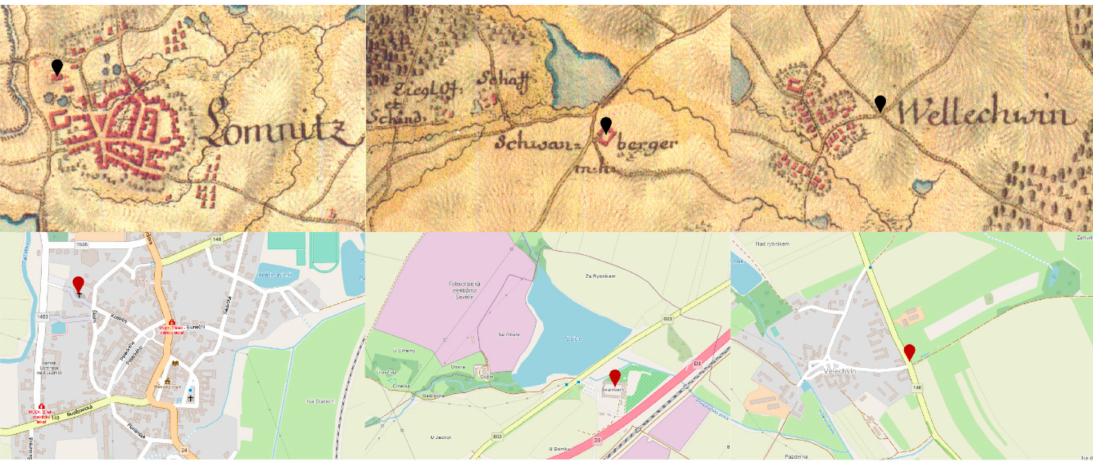
Figure 6. Examples of different types of GCPs collected (church, yard, path crossing).